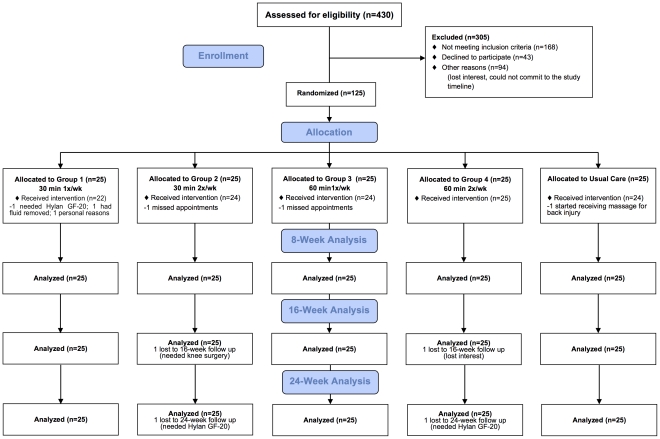
Participant Flow Diagram.